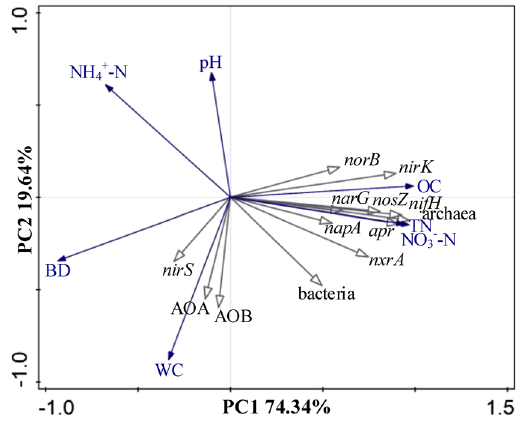
Figure 5. Principal component analysis of soil properties (Bulk density (BD), pH, total nitrogen (TN), organic carbon (OC), NH 4 + -N, NO 3 − -N, water content (WC), bacterial 16S rRNA (bacteria), archaeal 16S rRNA (archaea), and eleven N functional genes (i.e., AOA- amoA , AOB- amoA , nxrA , narG , napA , nirK , nirS , norB , nosZ , apr , and nifH ), along the artificial vegetation restoration. The first two PCA axes explain 74.34% of total variance.